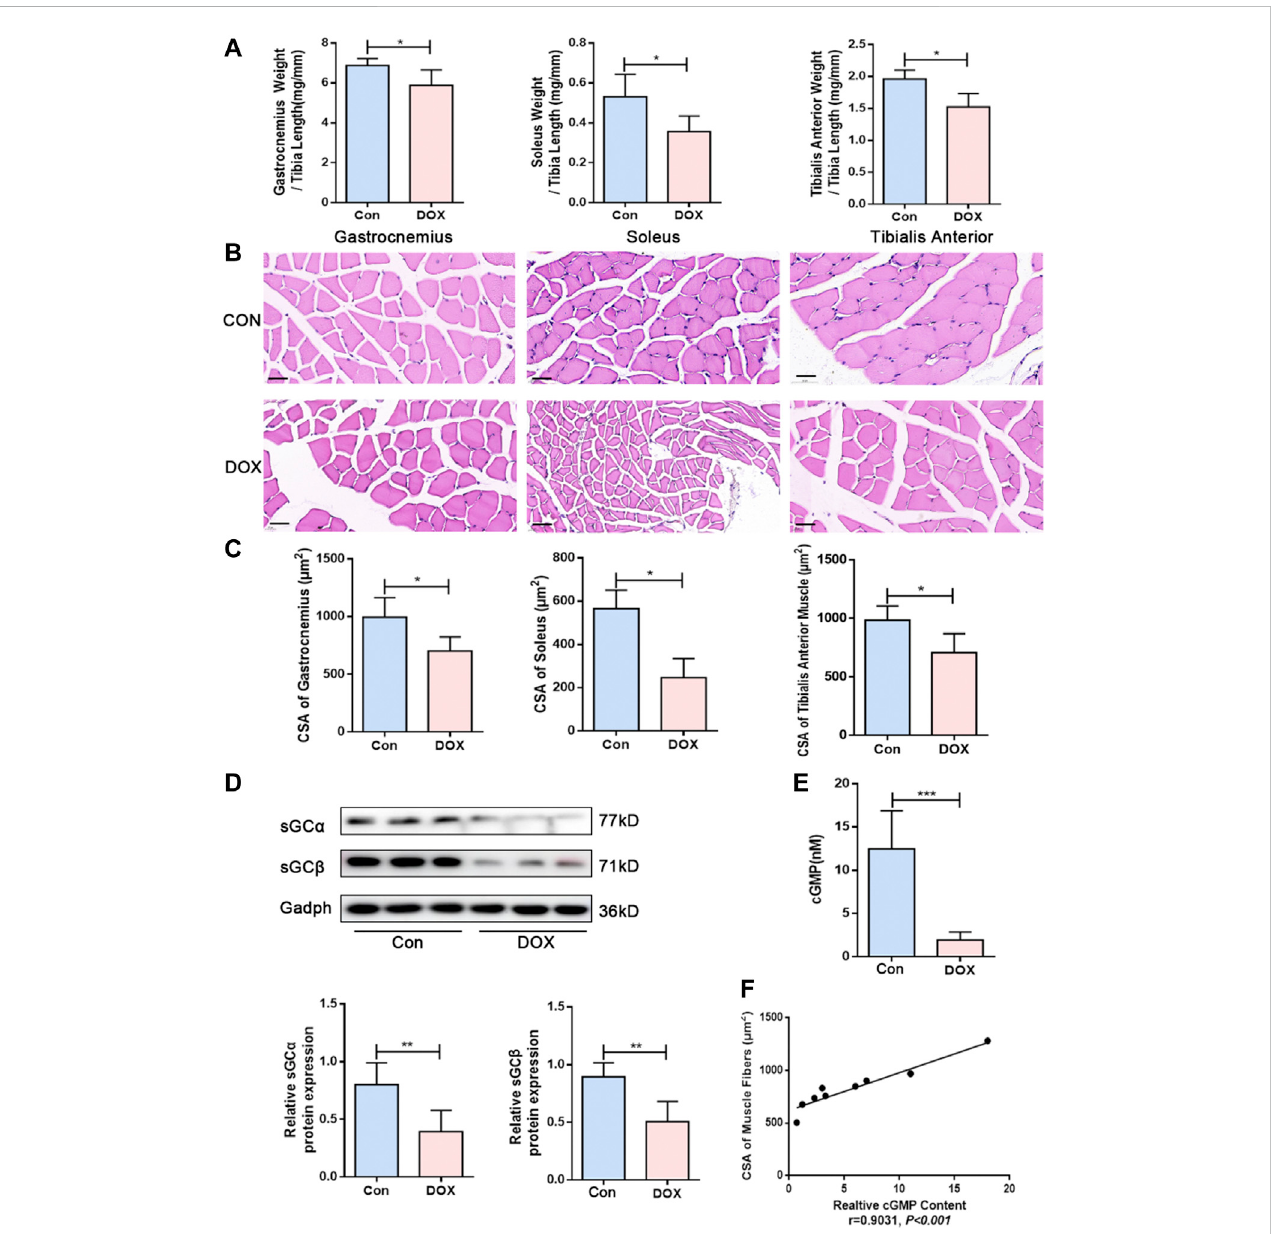
FIGURE 1 DOXinducedskeletalmuscleatrophyanddecreasedsGCactivityinmice. (A) Theratiosofthegastrocnemiusmuscle,soleusmuscle,andtibialisanterior muscle weight to tibia length (mg/mm). (B) Representative HE staining of different muscle CSA (Scale bar: 50 μ m). (C) CSA of muscle fi bers ( μ m 2 ). (D) Expressionsof sGC α and sGC β detected through western blot. (E) Detection ofcGMP content ingastrocnemius muscle byElisa. (F) Correlation between CSA of gastrocnemius muscle fi bers and cGMP content. n = 5; *p < 0.05, **p < 0.01, ***p <